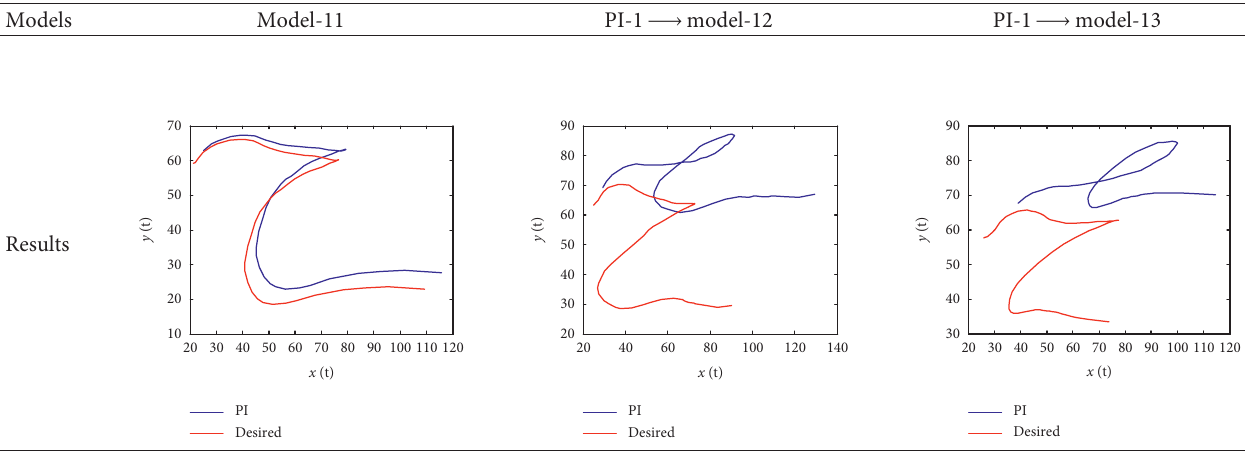
Table 4: Results of validation of the PI-1 controller applied to model-11, model-12, and model-13.